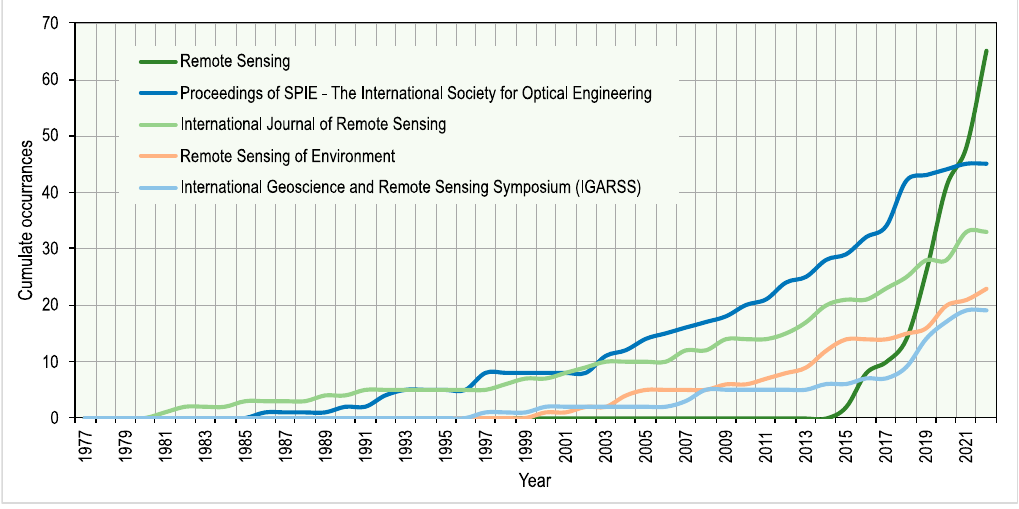
Figure 5. Dynamics of the cumulative number of documents in the top five journals over years.